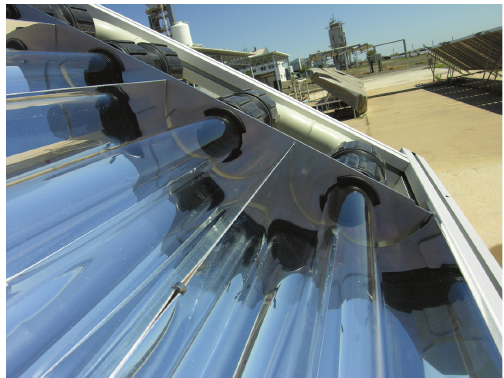
Figure 4: Borosilicate glass tubes with CPC.